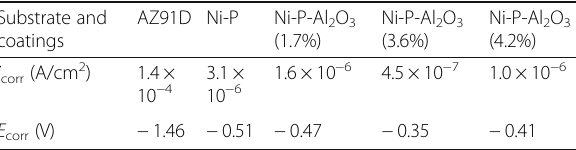
Table 2 Electrochemical corrosion data related to polarization curves of the magnesium alloy, the Ni-P coating, and the Ni-P- Al 2 O 3 composite